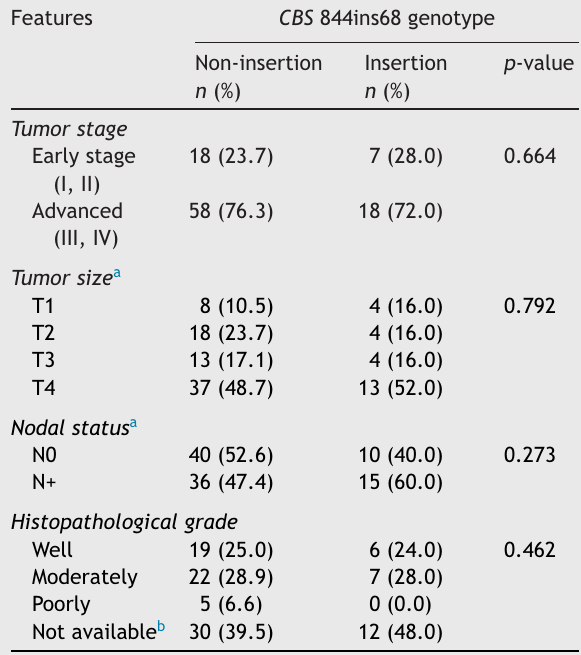
Clinicopathological characteristics of patients with OSCC and relation with the CBS polymorphism studied.